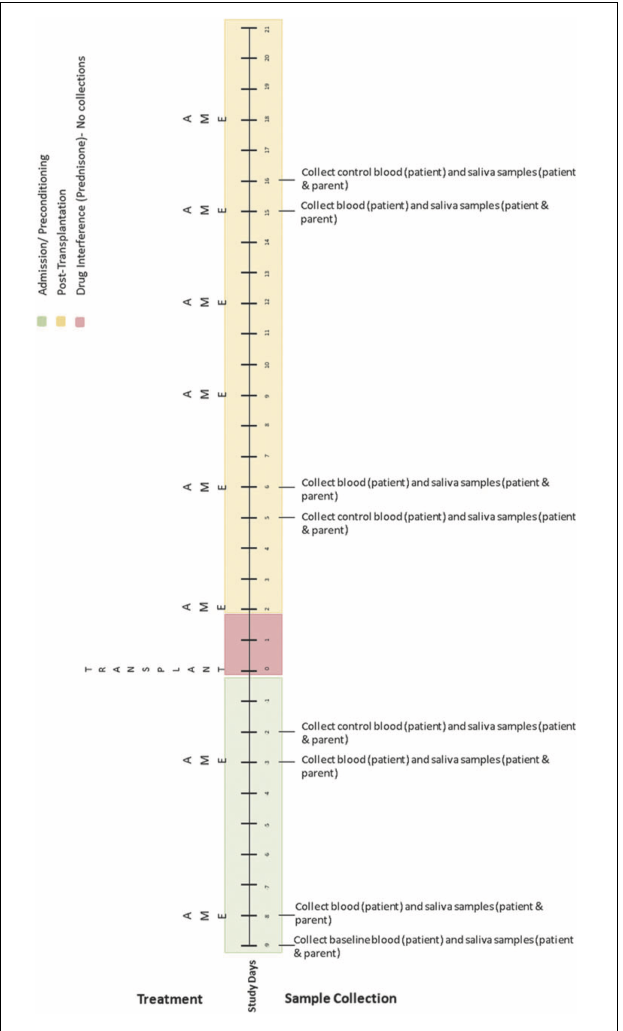
FIGURE 2 | Collection schedule for children undergoing autologous transplant. Reprinted from Russ et al. (2020).